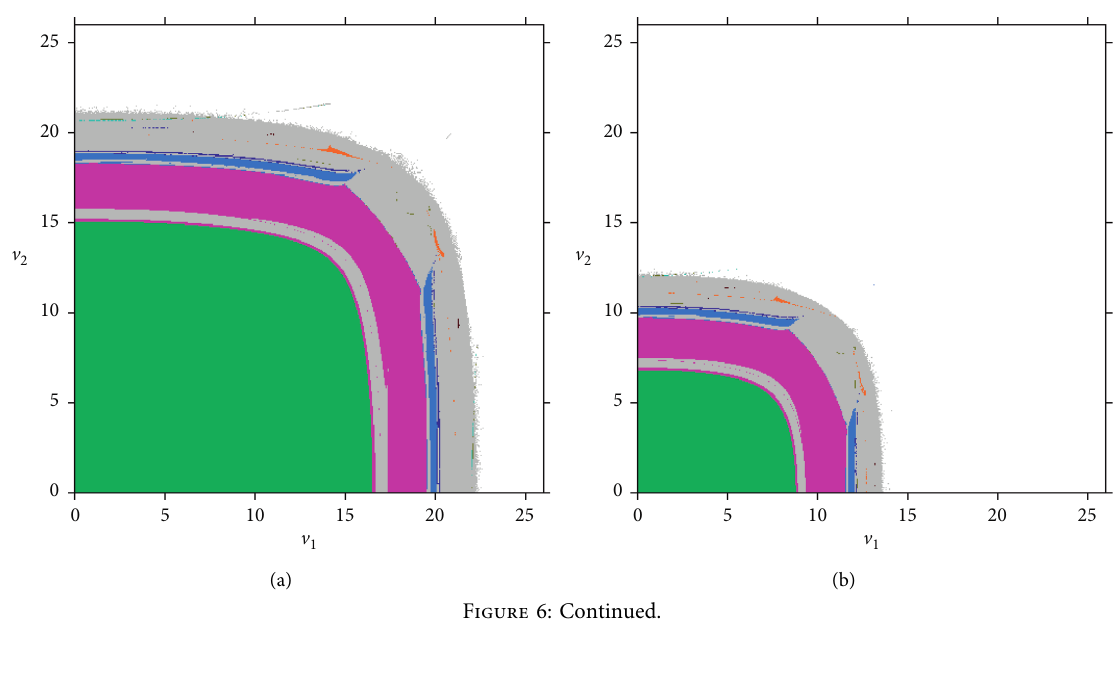
, δ ) plane with R r changing. (a) R 1 2